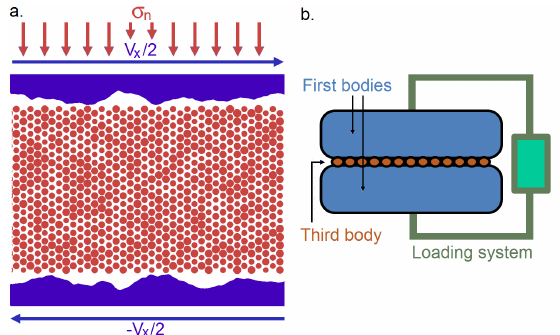
Figure 1: Conceptualization of the problem: a . Gen- eral configuration of a confined sheared granular flow under a normal stress σ n and a relative velocity V x ; b . The tribological triplet, including the three tribological